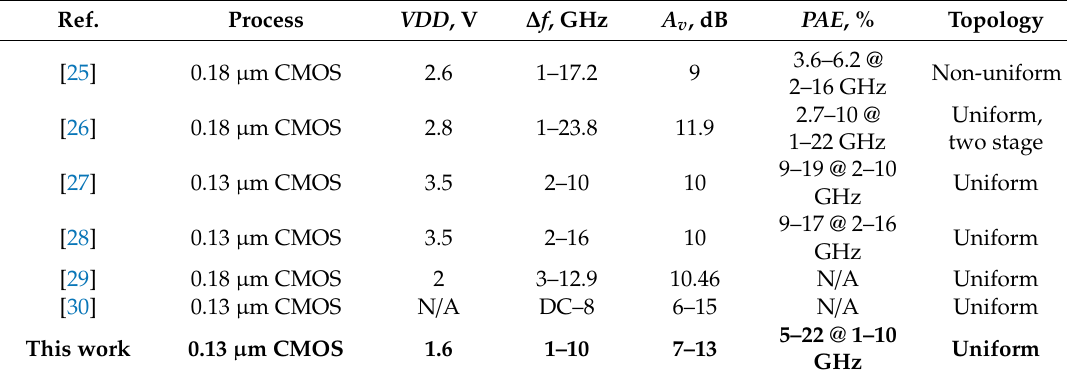
Table 1. Reported TWA parameter